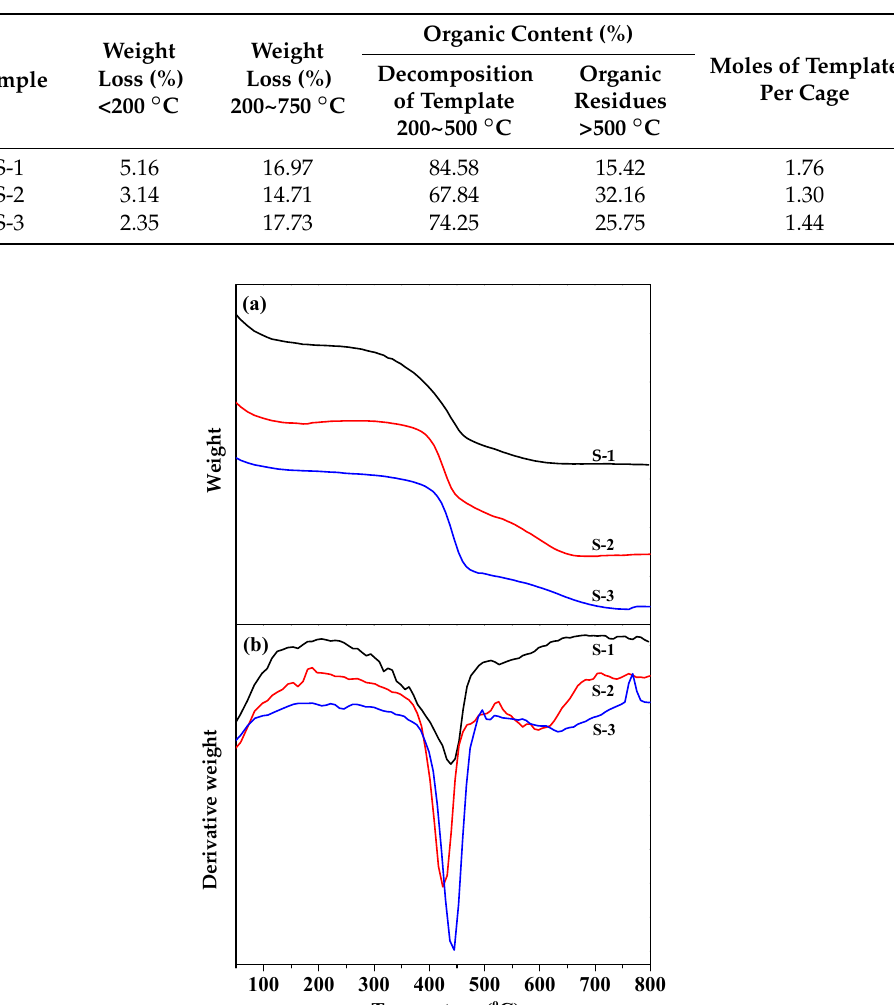
Table 2. The TG analysis results for samples synthesized by different templates.